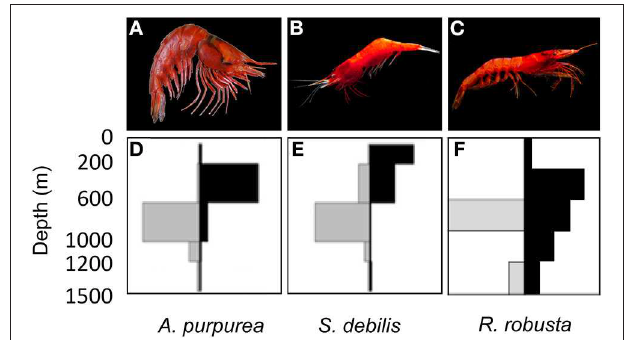
FIGURE 1 | Three species of mesopelagic shrimp targeted in this study, including the oplophorids (A) Acanthephyra purpurea (Milne-Edwards, 1881a) (photo credit: Dr. T.-Y. Chan) and (B) Systellaspis debilis (Milne-Edwards, 1881b) (photo credit: Dr. Danté Fenolio), and the sergestid (C) Robustosergia robusta (Smith, 1882) (photo credit: Dr. Danté Fenolio). Discrete depth abundances are reported for A. purpurea and S. debilis (D,E) , respectively ( Burdett et al., 2017) and R. robusta (F) (Frank, pers. comm.). Relative abundances, indicated by bar length, are plotted by depth (in meters) and solar cycle (“Day” is represented by gray bars to the left; “Night” is represented by black bars to the